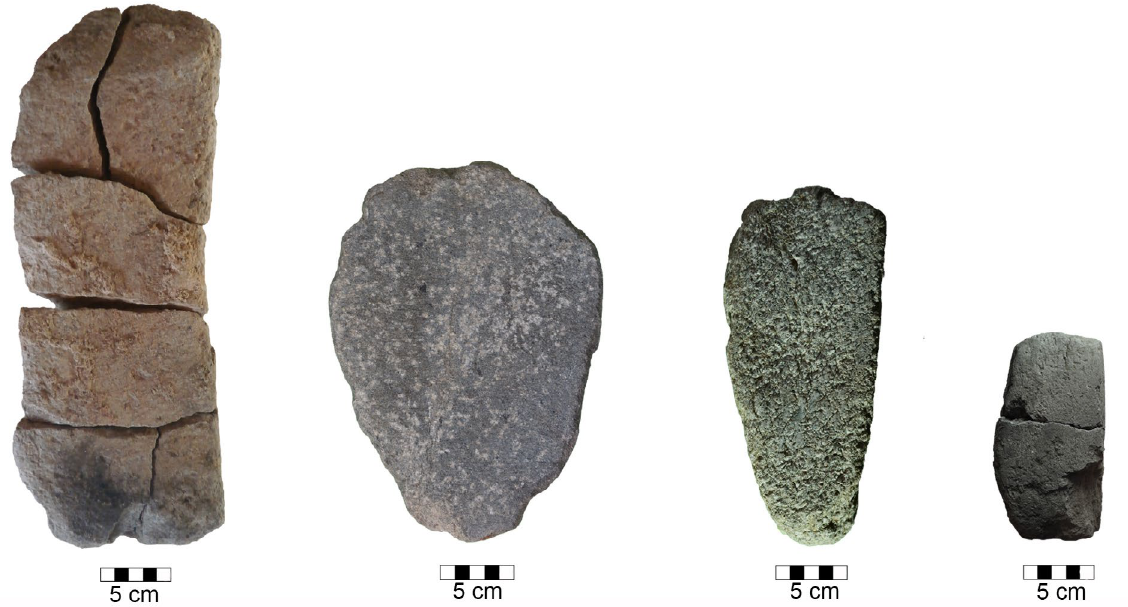
Figure 2. Grinding implements from various assemblages under study (ERC